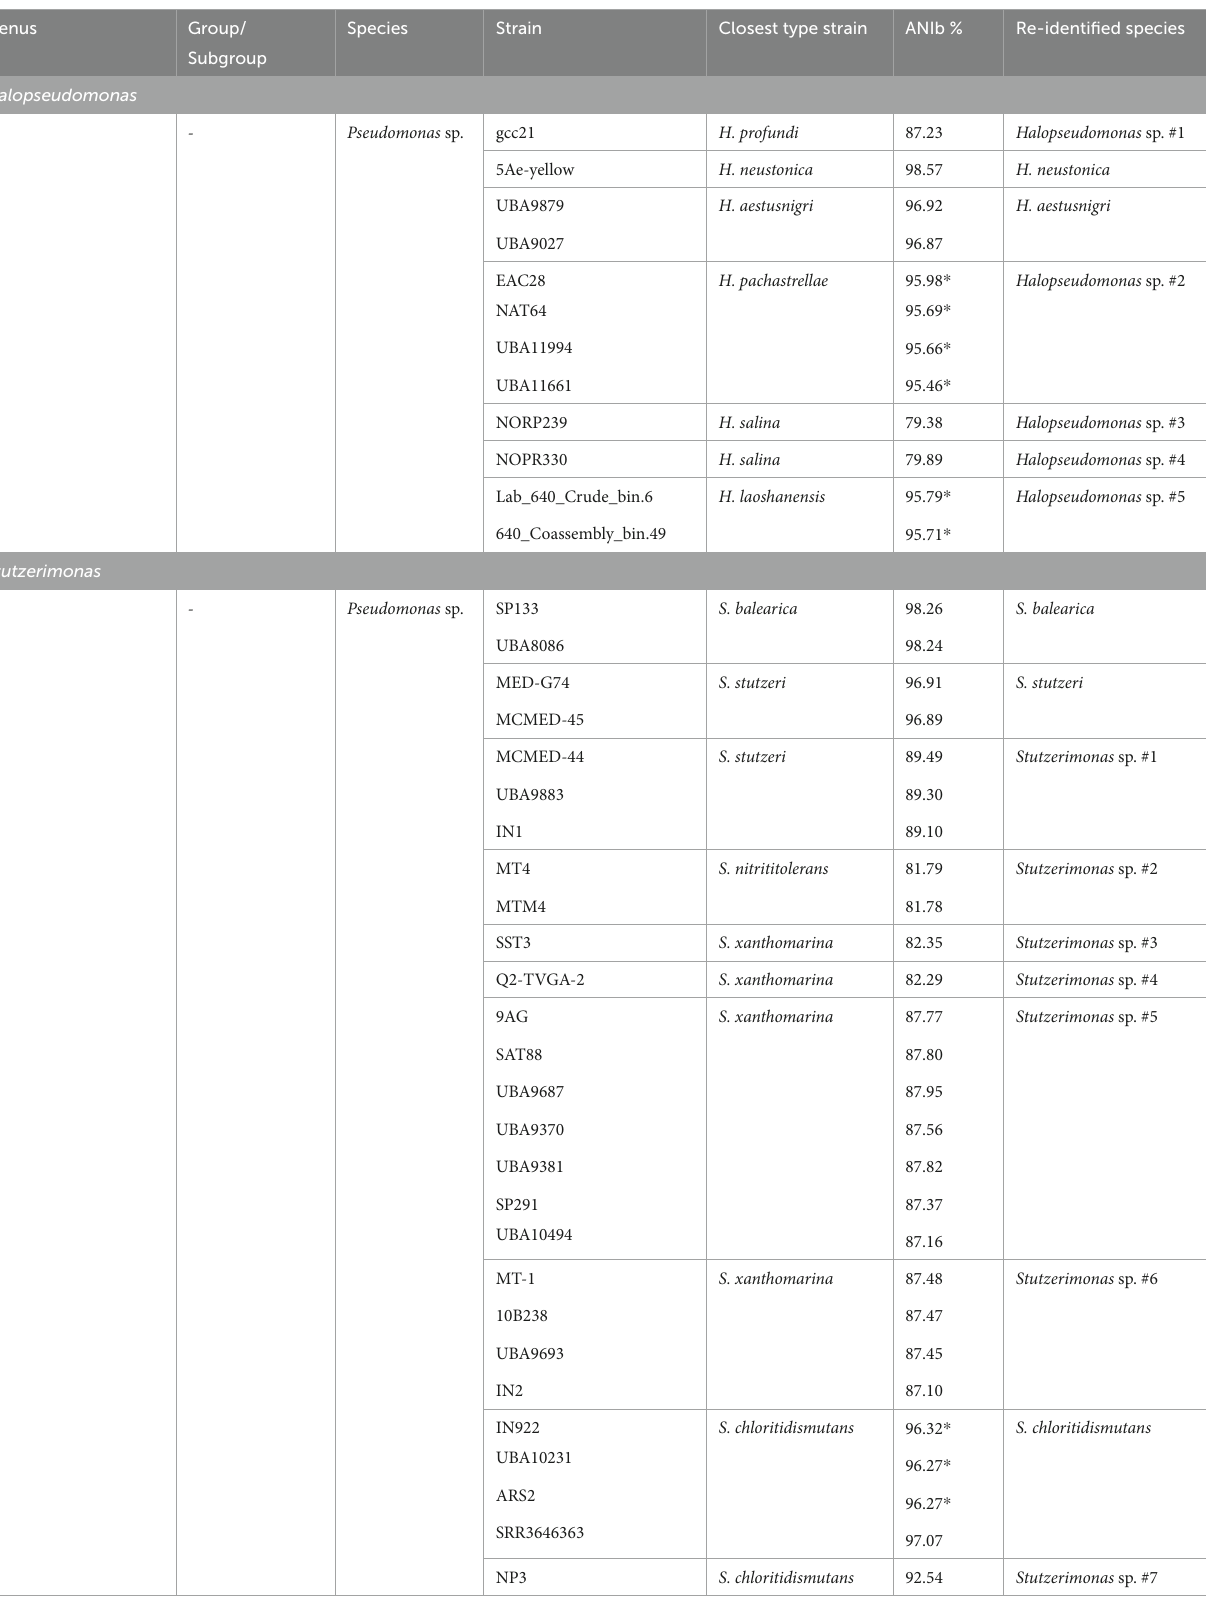
TABLE 1 Phylogenetic affiliation based on ANIb values for the 77 strains, previously not assigned or incorrectly assigned at the species level (Supplementary Table S4). Accession numbers are shown in Supplementary Table S3. Genus Group/